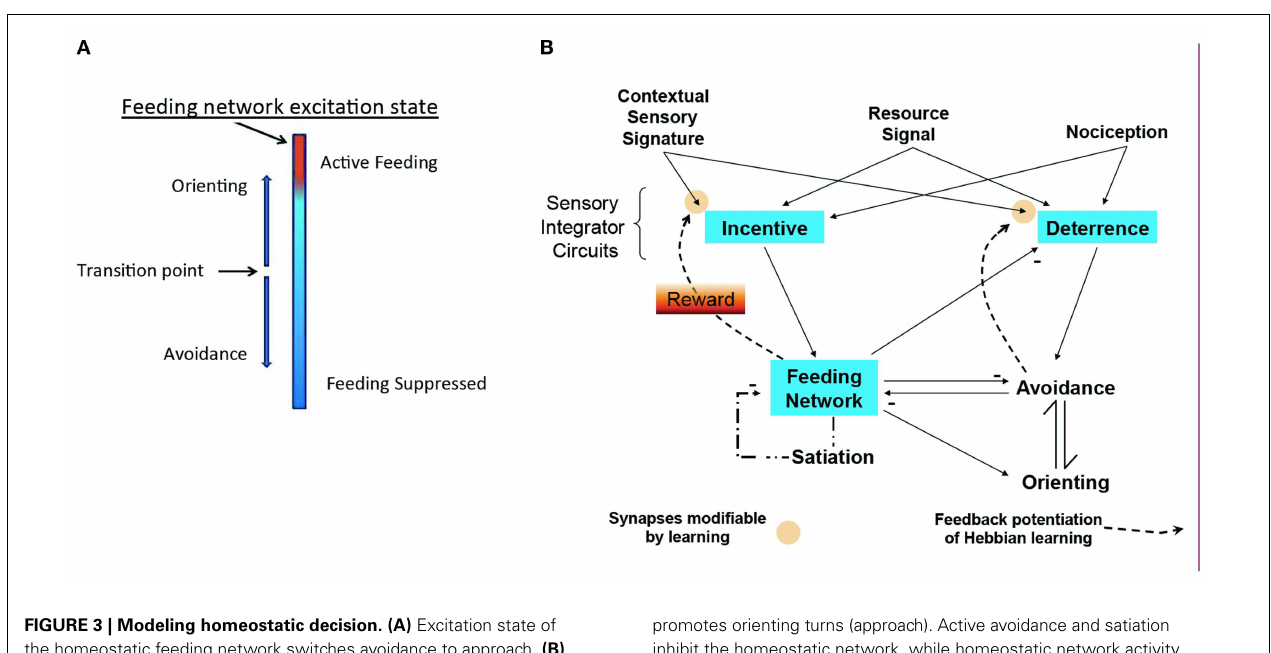
FIGURE 3 | Modeling homeostatic decision. (A) Excitation state of the homeostatic feeding network switches avoidance to approach. (B) Sensory inputs for resource quality, sensory signatures, and nociception access sensory networks for Incentive and Deterrence , which promote excitation of feeding and avoidance turns, respectively. Excitation in the homeostatic network suppresses avoidance and